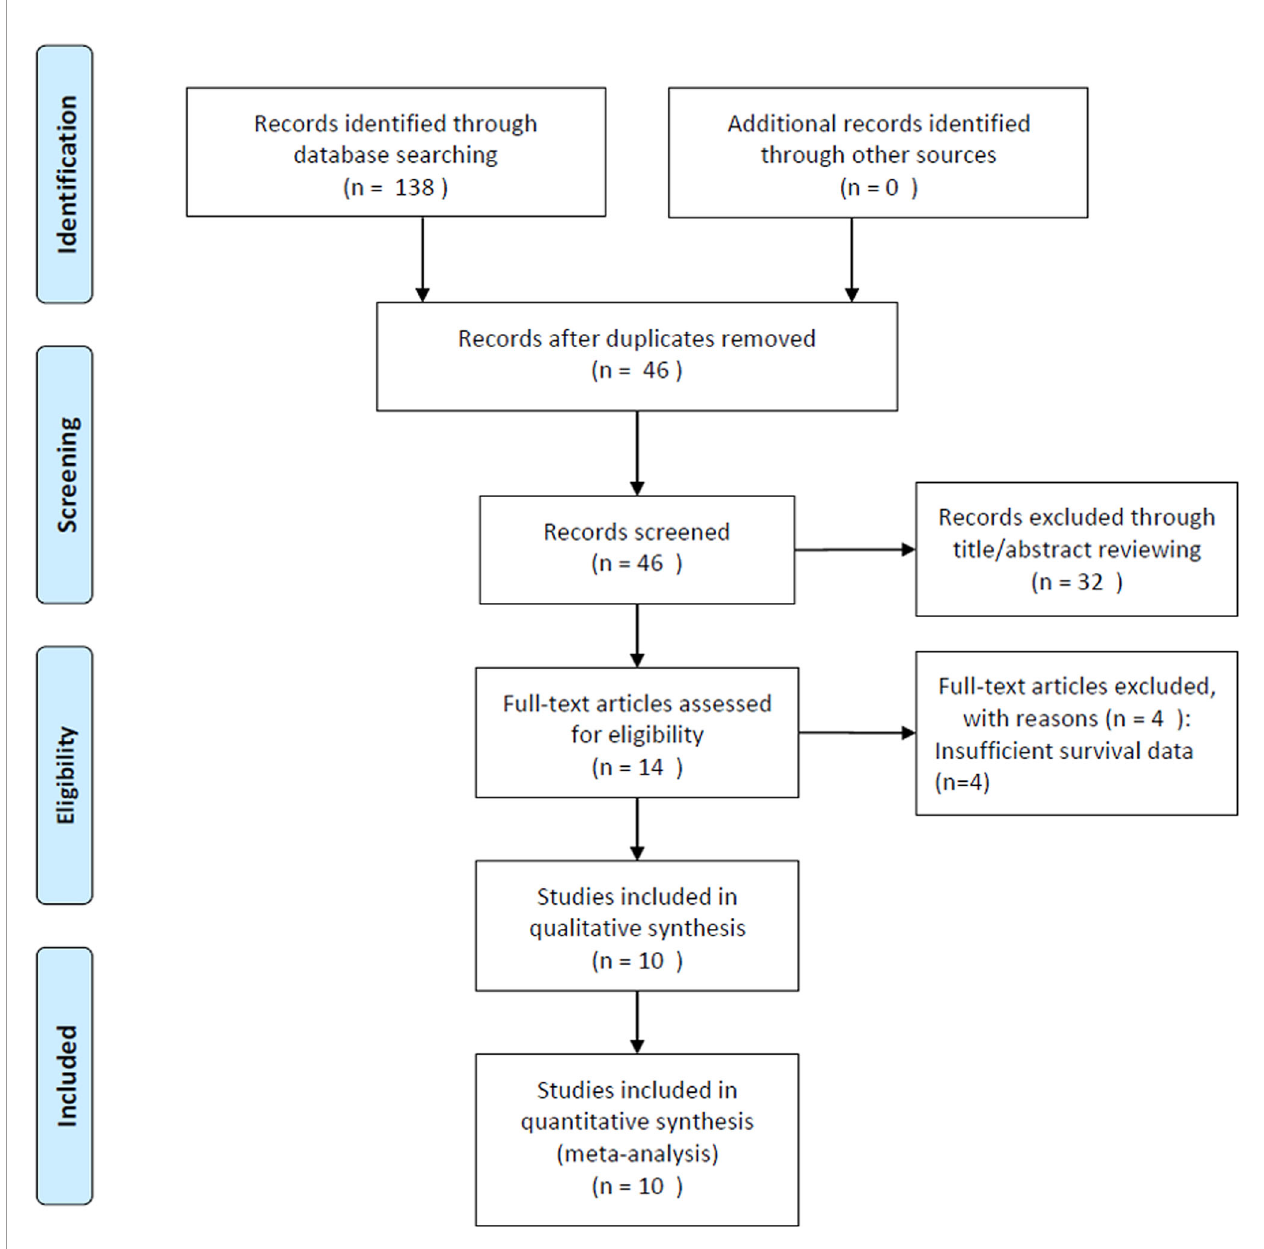
FIGURE 1 | Flow diagram of included studies for this